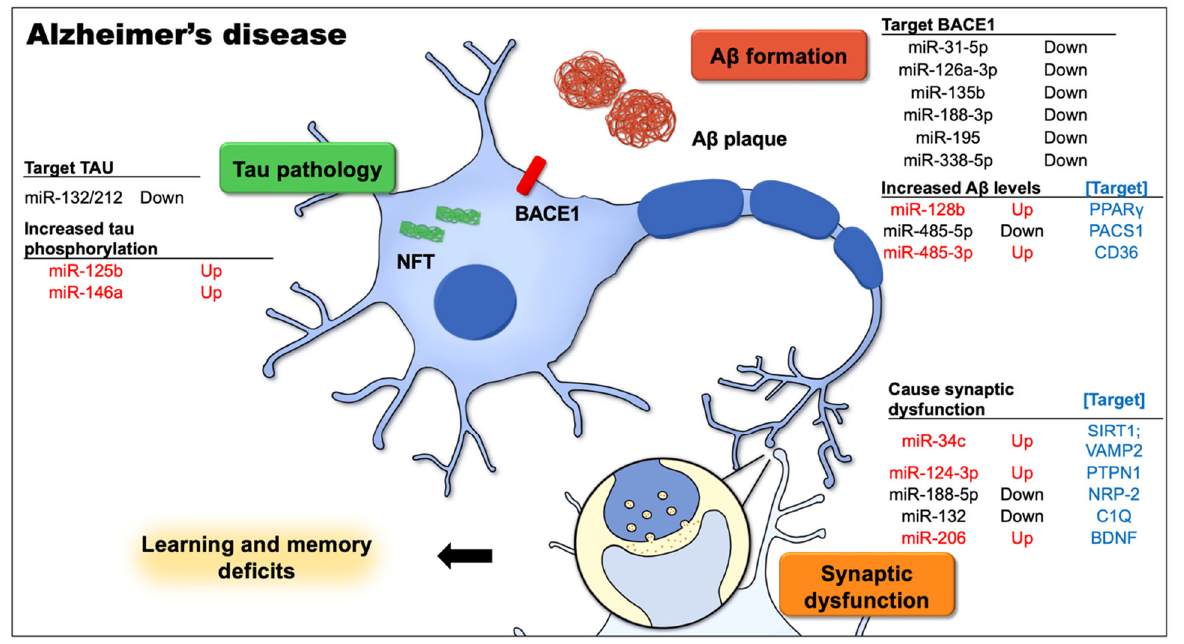
Figure 1. This figure demonstrates the most well ‐ known Alzheimer’s disease (AD) ‐ related cellular and signaling pathways in neurons that contribute to learning and memory deficits, and the dysregulated microRNAs along with the targets involved in the pathophysiological process of AD. The causative factors for AD, including the aggregation of intracellular amyloid ‐β (A β ), expression levels and activity of β‐ site APP cleavage enzyme 1 (BACE1), extracellular amyloid plaques, and neurofibrillary tangles (NFTs) from hyperphosphorylated tau, together with A β‐ mediated synapse elimination and synaptic failure, may lead to cognitive